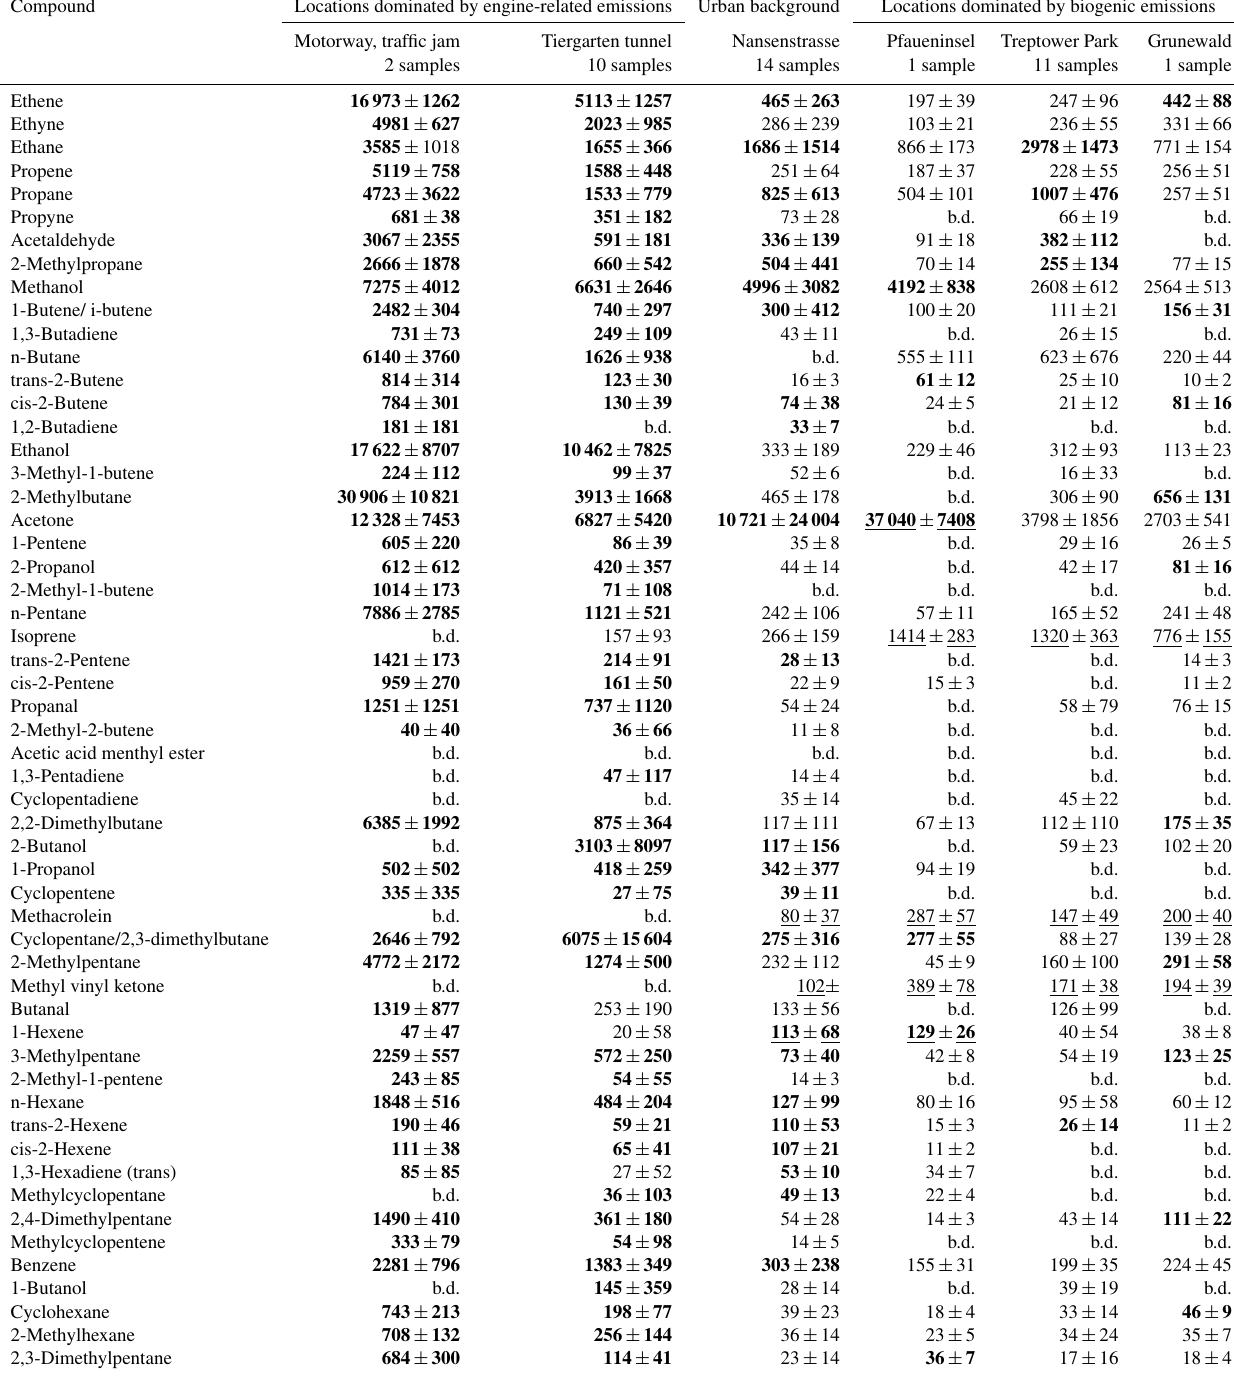
Table 8. Canister samples analyzed for VOC compositions. An ozone scrubber was applied in front of the inlet to prevent sampling losses and artifacts. All values are provided as mean volume mixing ratios in ppt v . The different environments are grouped and the number of available samples is provided for each case. The third column represents urban background measurement conditions at Nansenstrasse (urban background standard). Elevated anthropogenic compounds with respect to vegetated background area concentration ( > average + 2SD of the two smaller mixing ratios of vegetated areas) are marked in bold. Underlined numbers mark biogenic compounds exceeding the average of the two smaller mixing ratios for anthropogenic dominated areas ± 2 standard deviations. Marked numbers represent the compounds substantially affecting the area with no predominant emissions. b.d. abbreviates below detection